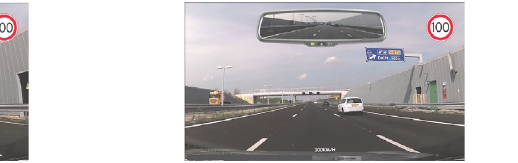
Table 2: Overview of the questions: screenshot (all but the first row cropped due to space limitation), question number, theme of question (in bold), and